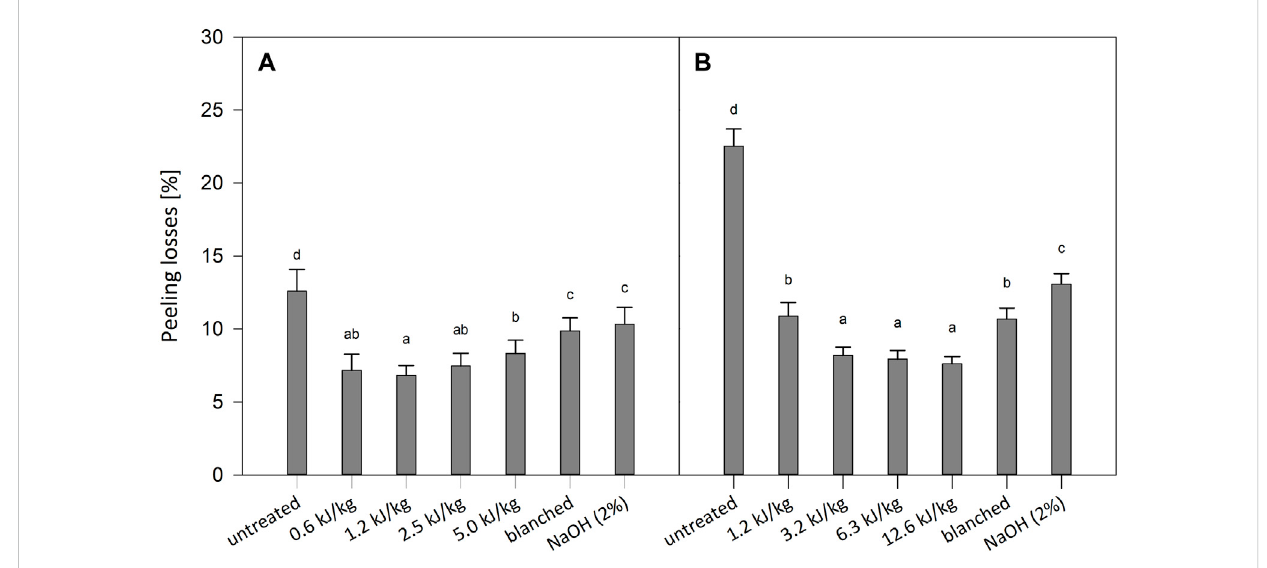
FIGURE 3 Peeling loss for untreated, PEF treated, blanched and lye peeled tomatoes (A) and kiwi fruits (B) . Signi fi cant differences are indicated by different letters ( p <